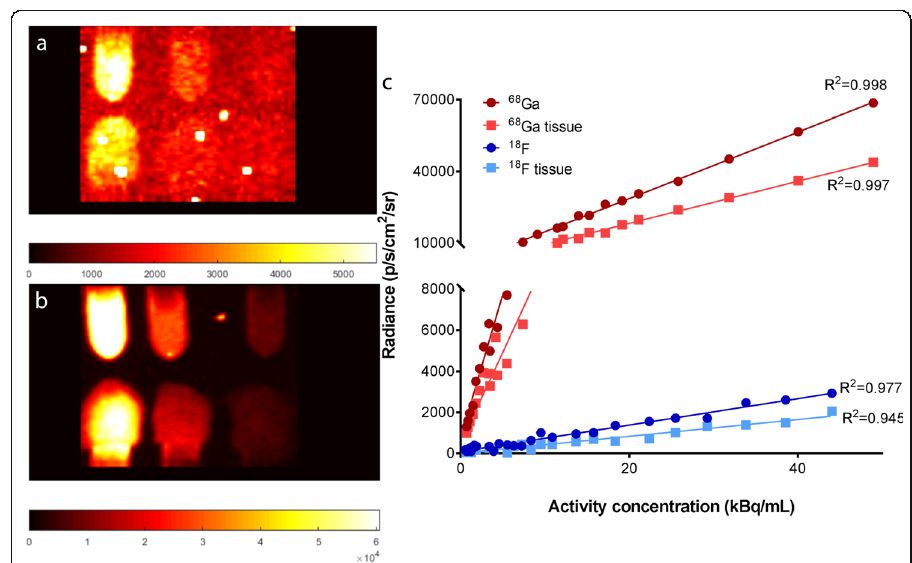
Fig. 1 Example of two CLI images of 6 Eppendorf tubes filled with 18 F ( a ) and 68 Ga ( b ), where the bottom row is overlayed with 1 mm tissue ( a ). From left to right the tubes are filled with 1 mL of 45, 12.5, and 2.5 kBq/mL activity. ( c ) Effect of tissue on linearity and signal intensity 18 F and 68 Ga. Data acquired with an exposure time of 120 s and binning 2 × 2. 68 Ga gives a 22× higher light yield compared to 18 F on average. The break line was added to the graph, to visualize the effect of tissue on the 18 F radiance. Without break line, this was not visible, due to the high radiance of 68 Ga